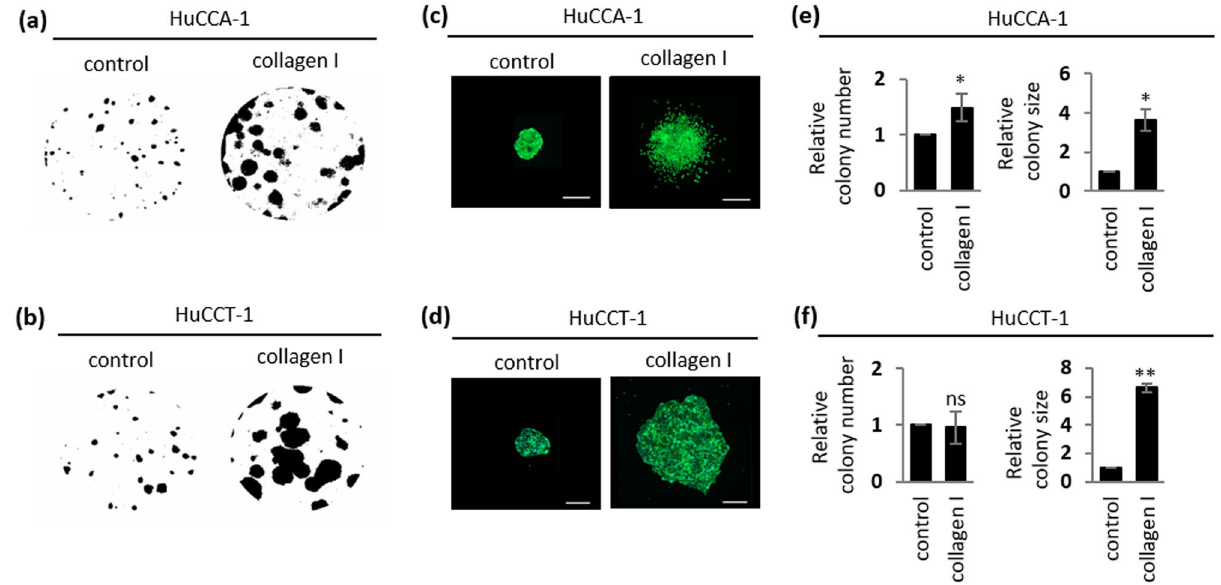
Figure 6. Collagen type I promotes clonogenic growth of iCCA cells. Parental HuCCA-1 and HuCCT-1 ± 10 μg/mL collagen type I in a 10-day clonogenic assay; ( a,b ) whole well images; ( c,d ) Alexa Fluor 488 Phalloidin-stained HuCCA-1 and HuCCT-1 colonies, Scale bar = 500 μm and ( e,f ) quantifications of colony number and size. All bar graphs represent the mean ± SD from at least three independent experiments. The Student’s t-test was used to calculate p -value. ns, not significant; * p < 0.05; ** p <